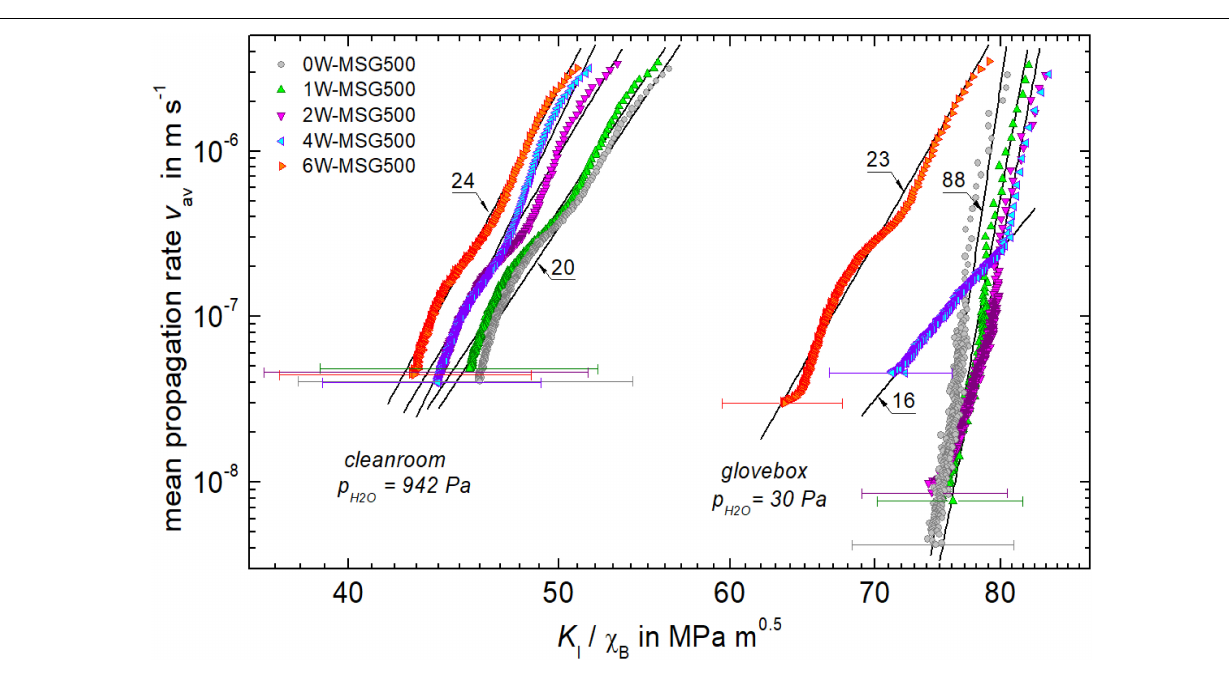
FIGURE 7 | Mean crack propagation rate v av vs. uncalibrated stress intensity K I / χ B . Lines of slope n (as indicated) are best linear fits through data. Error bars show standard deviation of the crack length distributions of Table 2